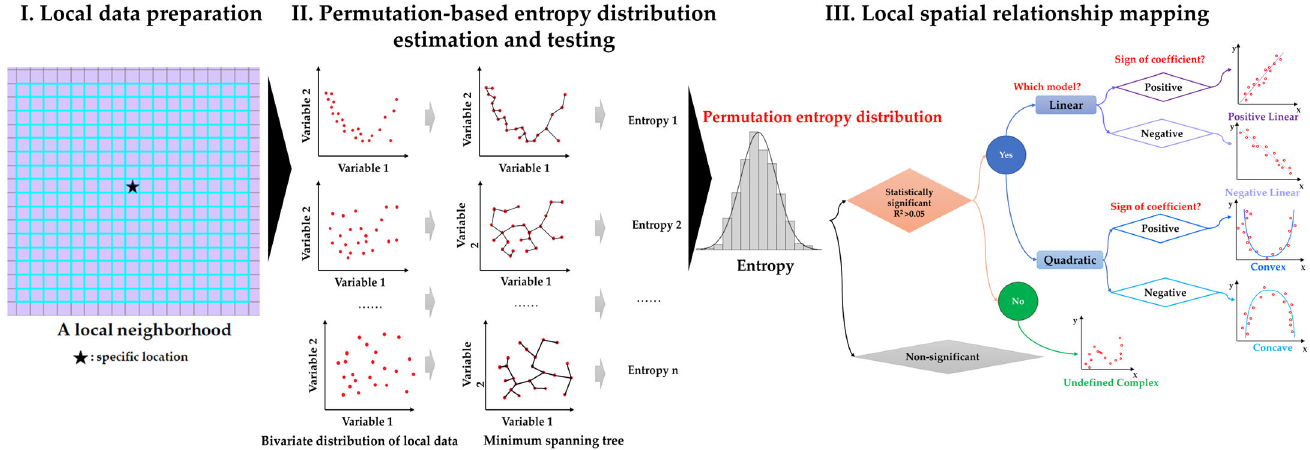
Figure 3. Research flowchart of local bivariate analysis. Note: The flowchart of local bivariate analysis was designed and revised based on Guo’s study [29], consisting of three steps: (I) local data preparation; (II) permutation-based entropy distribution estimation and testing; and (III) local spatial relationship mapping.